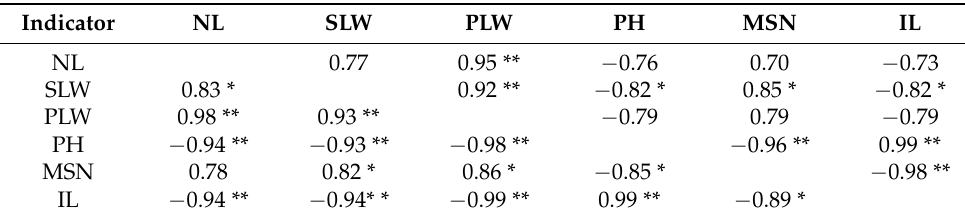
Table 3. Correlation analysis of growth indicators among soybean plants and C. bilineata tsingtauica in spring sowing net